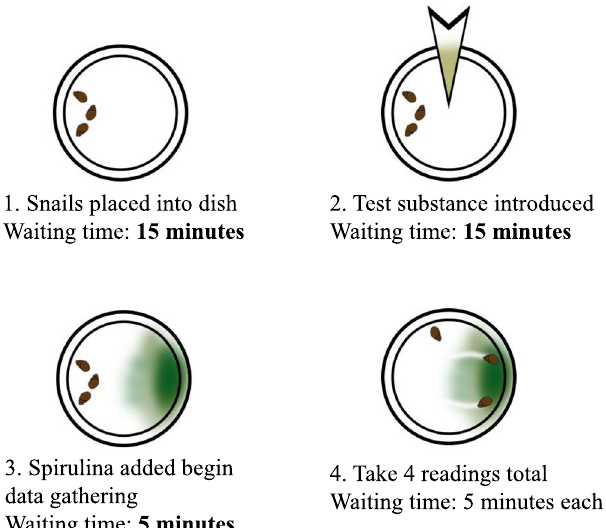
Figure 3. Illustration of the methodology used to test snails’ movement and behaviors. Step 1: three snails were put on every dish and provided 15 minutes acclimation time. Step 2: the test substances were